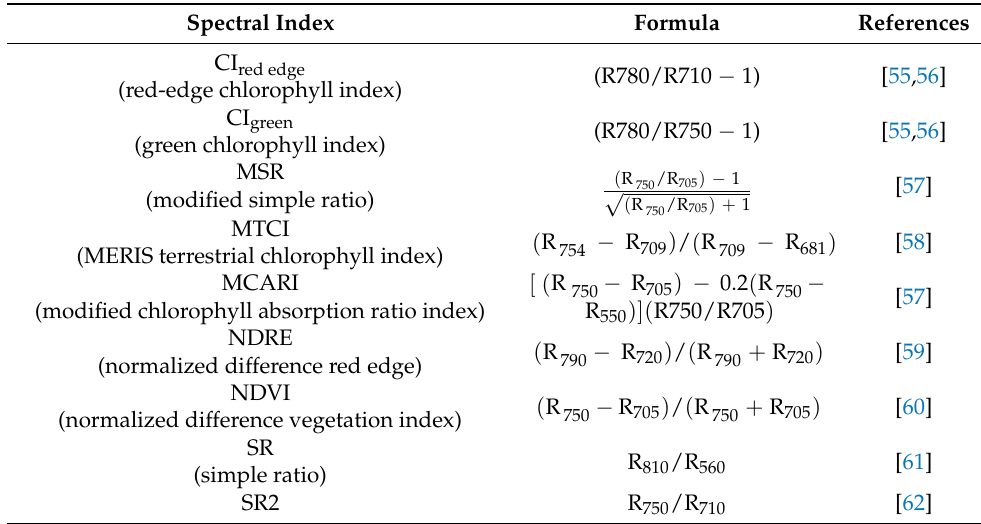
Table 1. Selected spectral indices.